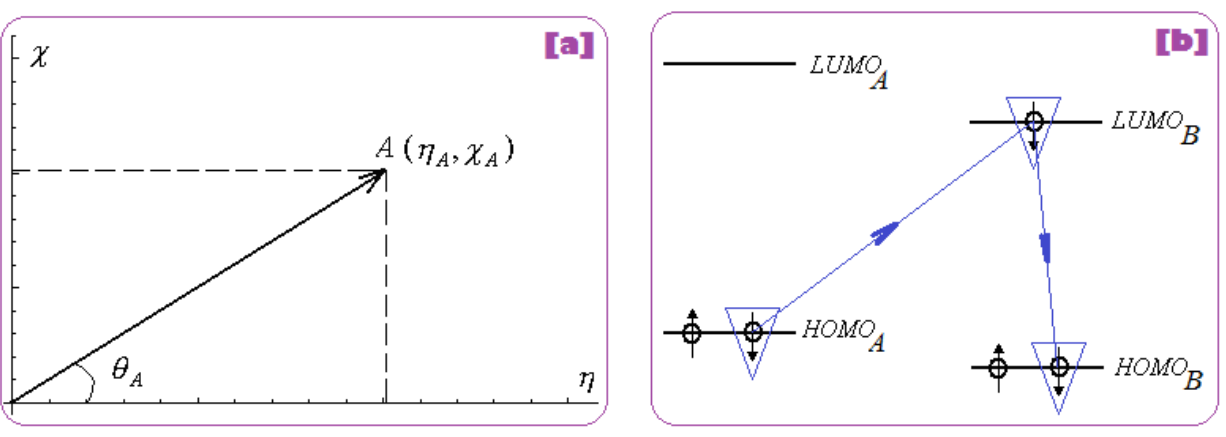
Figure 1. ( a ) Orthogonal hardness-electronegativity ( χη− ) representation for an χη , ); ( b ) the “ABB” mechanism of electronic system with coordinate A ( AA